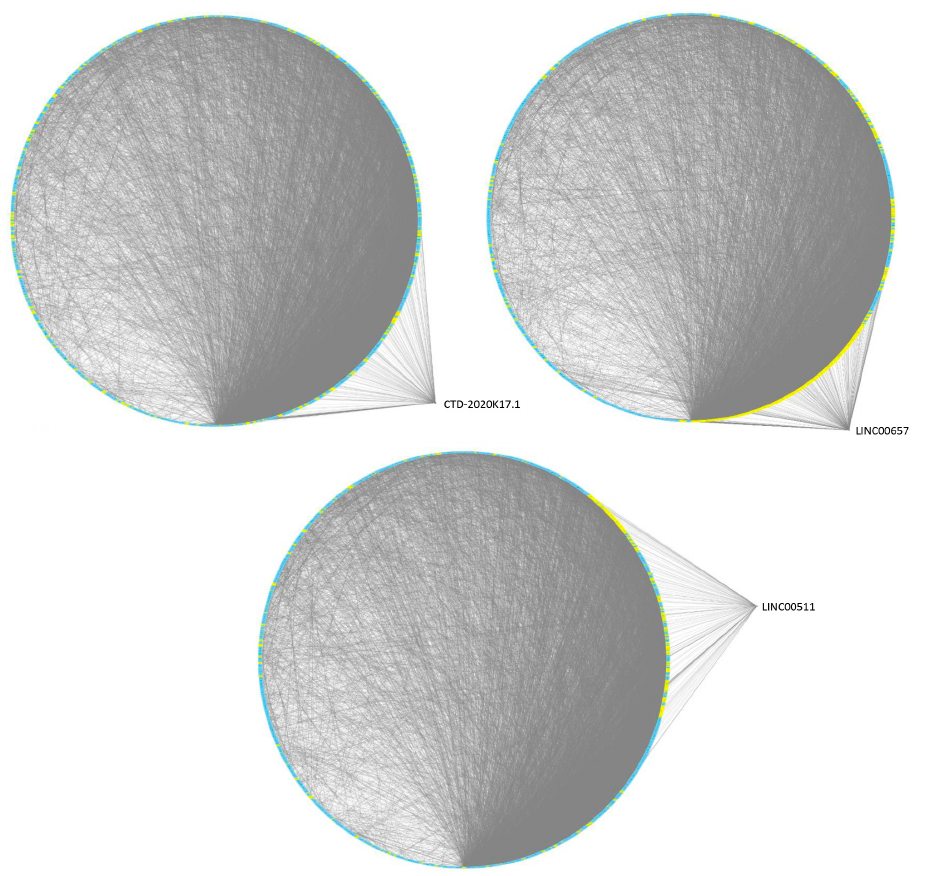
Figure 2. Functional interactions among the three selected lncRNAs and genes modulated in pSjS patients. Degree sorted circle layouts of the protein–protein interaction (PPI) network of differentially expressed genes in pSjS patients are shown. Genes (nodes) are ordered around a circle based on their degree of connectivity (number of edges).